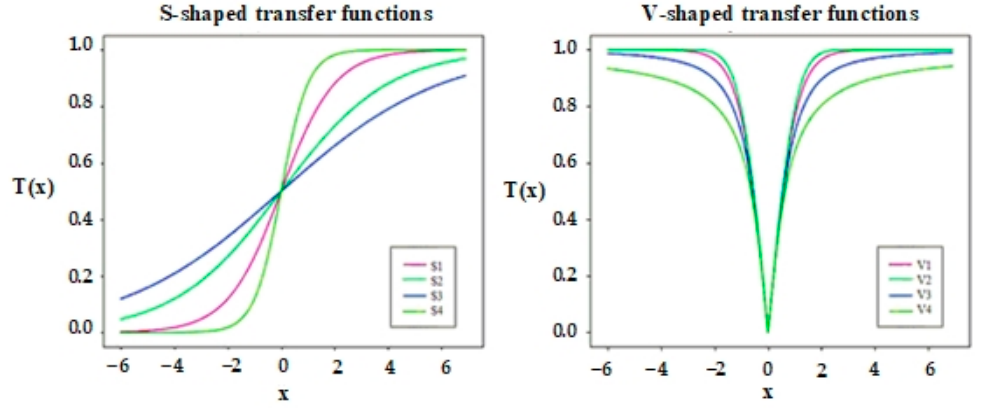
Figure 2. The S-shaped and V-shaped transfer functions [89] . Table 1. The formulation of S-shaped and V-shaped transfer